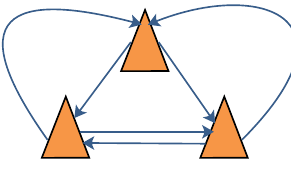
Figure 6. Communication graph for 3 robots.